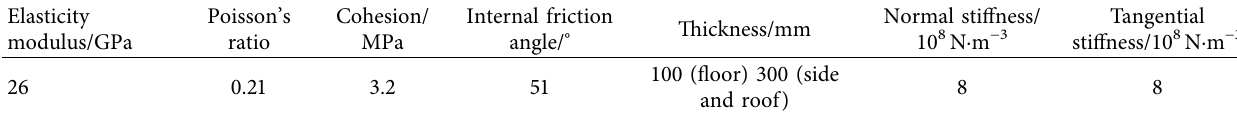
Table 3: Numerical calculation parameters of